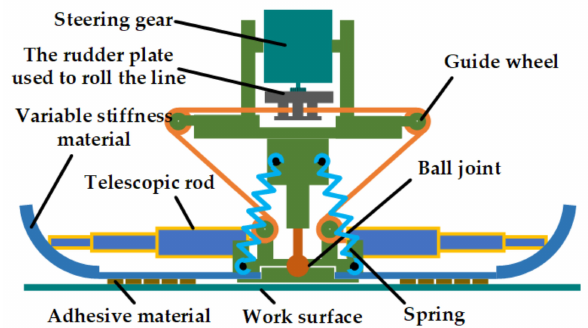
Figure 12. Structure of the gecko-inspired foot.